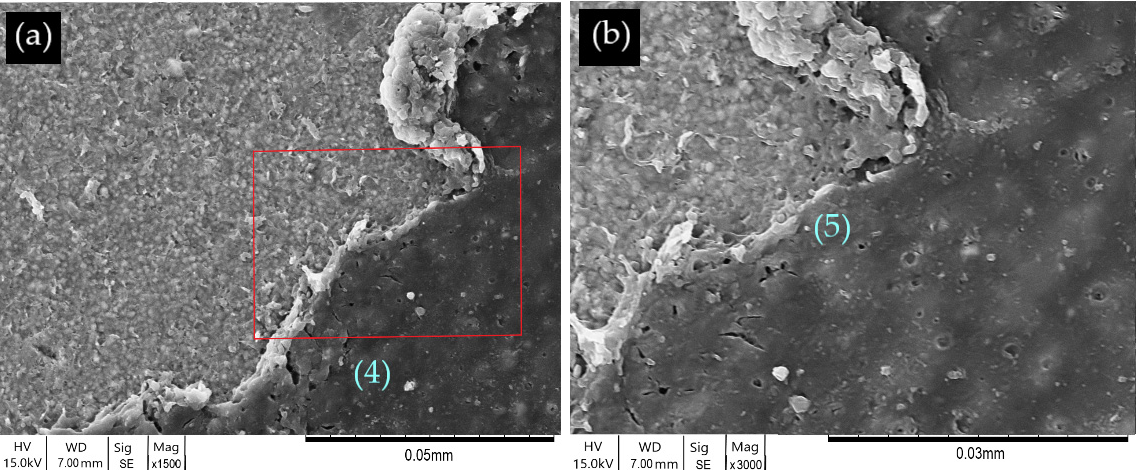
Figure 9. SEM images of Coating B after pin-on-disc Test 1b: ( a ) ×1500 magnification, ( b ) ×3000 magnification.